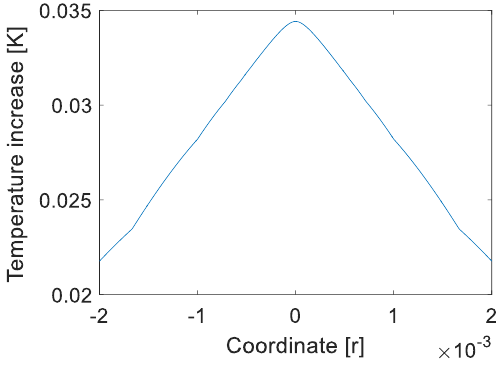
Fig. 1. The temperature increase in the sample along the radial coordinate